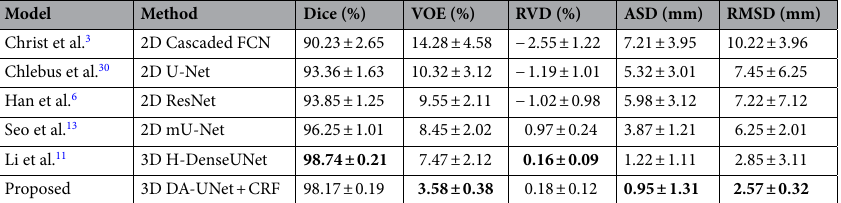
Table 4. Comparisons with the SOTA methods on 3DIRCADb test datasets. Significant values are in bold.